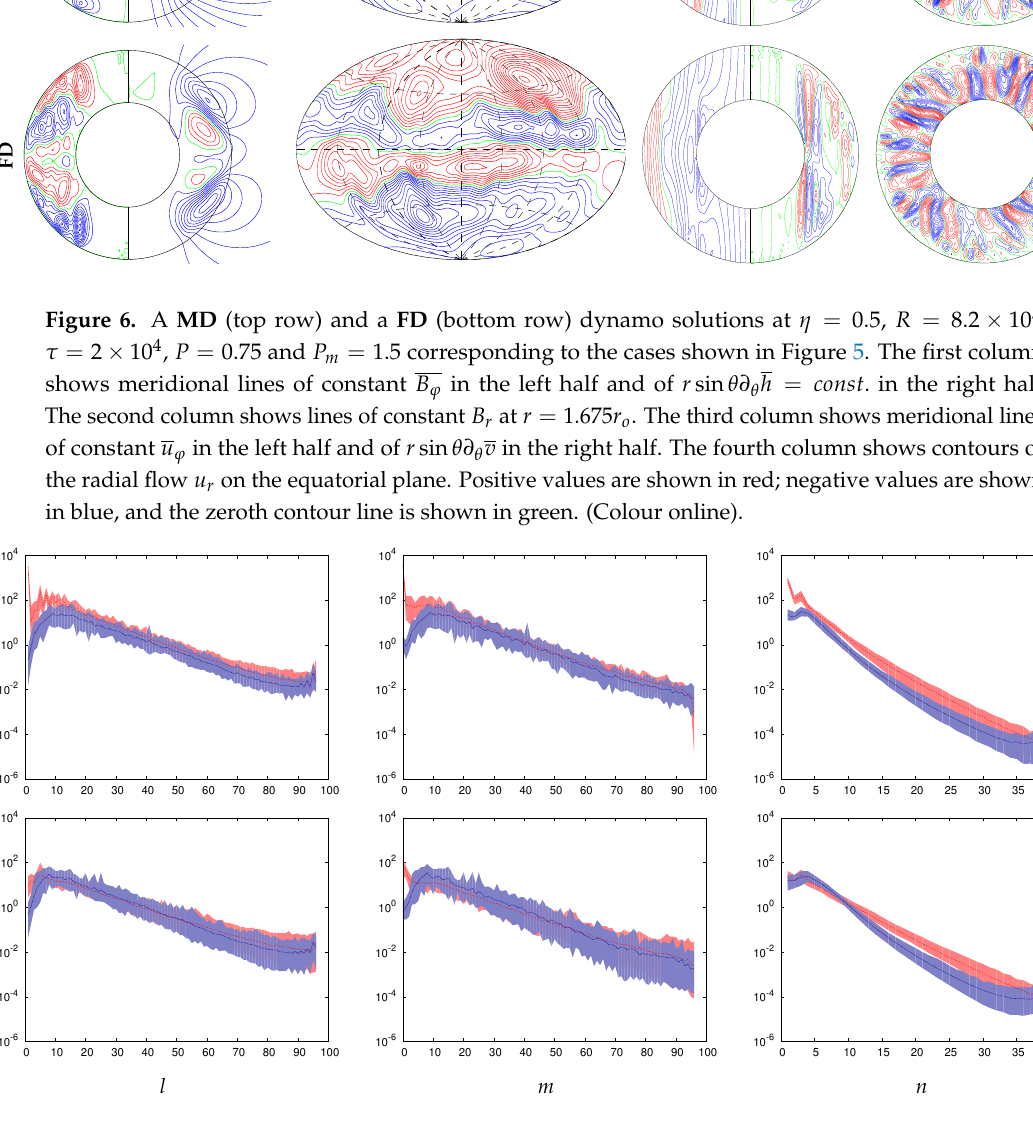
Figure 7. Typical power spectra of velocity (blue) and magnetic field (red). The top row shows an MD dynamo solution whereas the bottom row shows an FD dynamo solution both at η = 0.4, 10 4 , P = 0.75 and P m = 1.5. From left to right, power spectra as a function of R = 1,500,000, τ = 2 × the spherical harmonic degree l , order m , and Chebychev polynomial degree n are shown, respectively. Lines represent the average spectra and shaded areas go from the minimum to the maximum values for each mode in the averaging period. A period of one viscous-diffusion time unit is used for the time-averaging period in both cases. (Colour